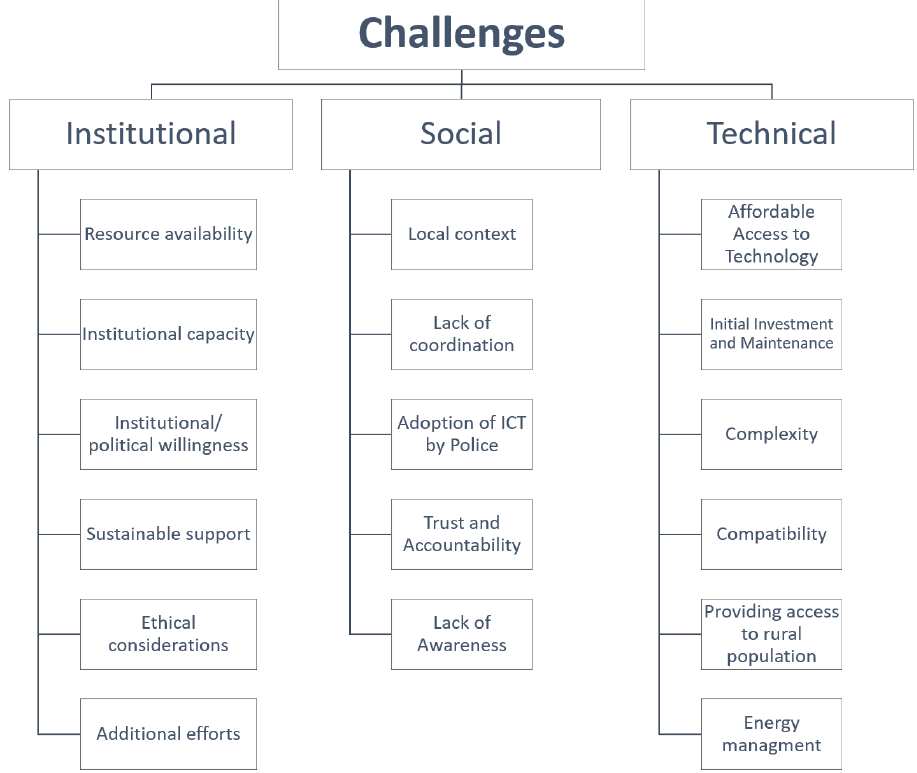
Figure 3. Categories of challenges faced by ICT-based